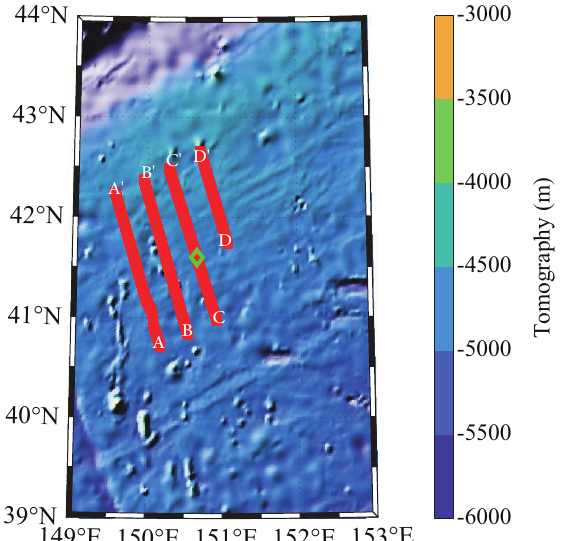
Figure 5. Topography of the western North Pacific. Colour shading indicates topographic relief from etopo1 data (global relief model of Earth’s surface, for more information https://www.ngdc.noaa. gov/mgg/global accessed on 1 April